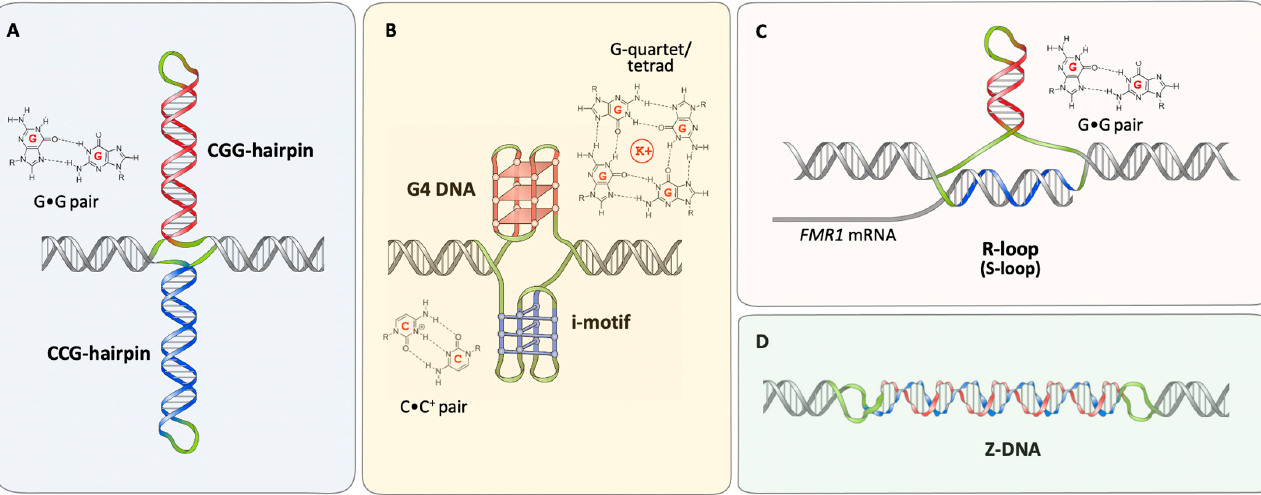
Figure 1. Generic representation of the types of DNA and RNA structures formed by FX repeats. Structures shown include hairpins formed by each strand of the repeat ( A ), a quadruplex or G4 DNA structure and an i-motif structure ( B ), an R-loop with associated hairpin formed by the non-template strand resulting in an S-loop ( C ) and Z-DNA ( D ). The CGG strand is shown in red and the CCG strand in blue. Unpaired loops regions are shown in green and the non-repetitive flanking DNA is shown in grey. Note that in addition to unpaired loop bases, some of these structures also contain non-Watson Crick base pairs or mismatches. The structures of the constituent non-canonical base interactions are shown alongside each structure.